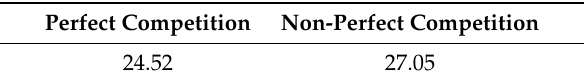
The average Belgium electricity price in March 2016 for perfect and non-perfect competition executions.